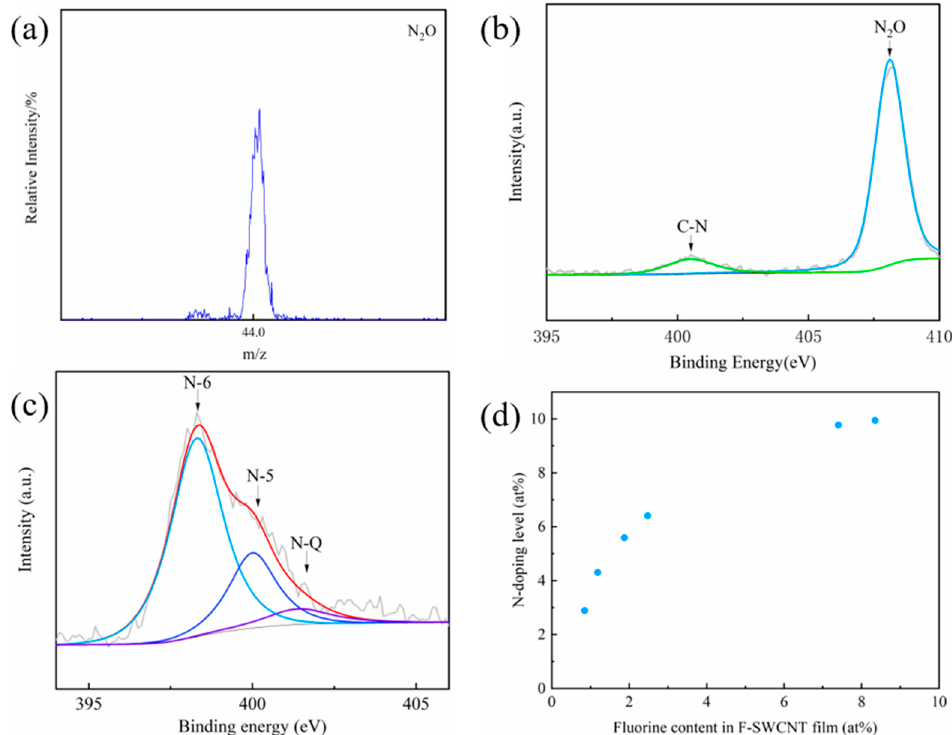
Figure 3. ( a ) SIMS spectrum of a F–SWCNT film showing the existence of N 2 O molecules. ( b ) N 1 s XPS spectra of a F–SWCNT film. ( c ) N 1 s XPS spectra of a N–SWCNT film. ( d ) Dependence of the N–doping content on the degree of fluorination of the SWCNTs.